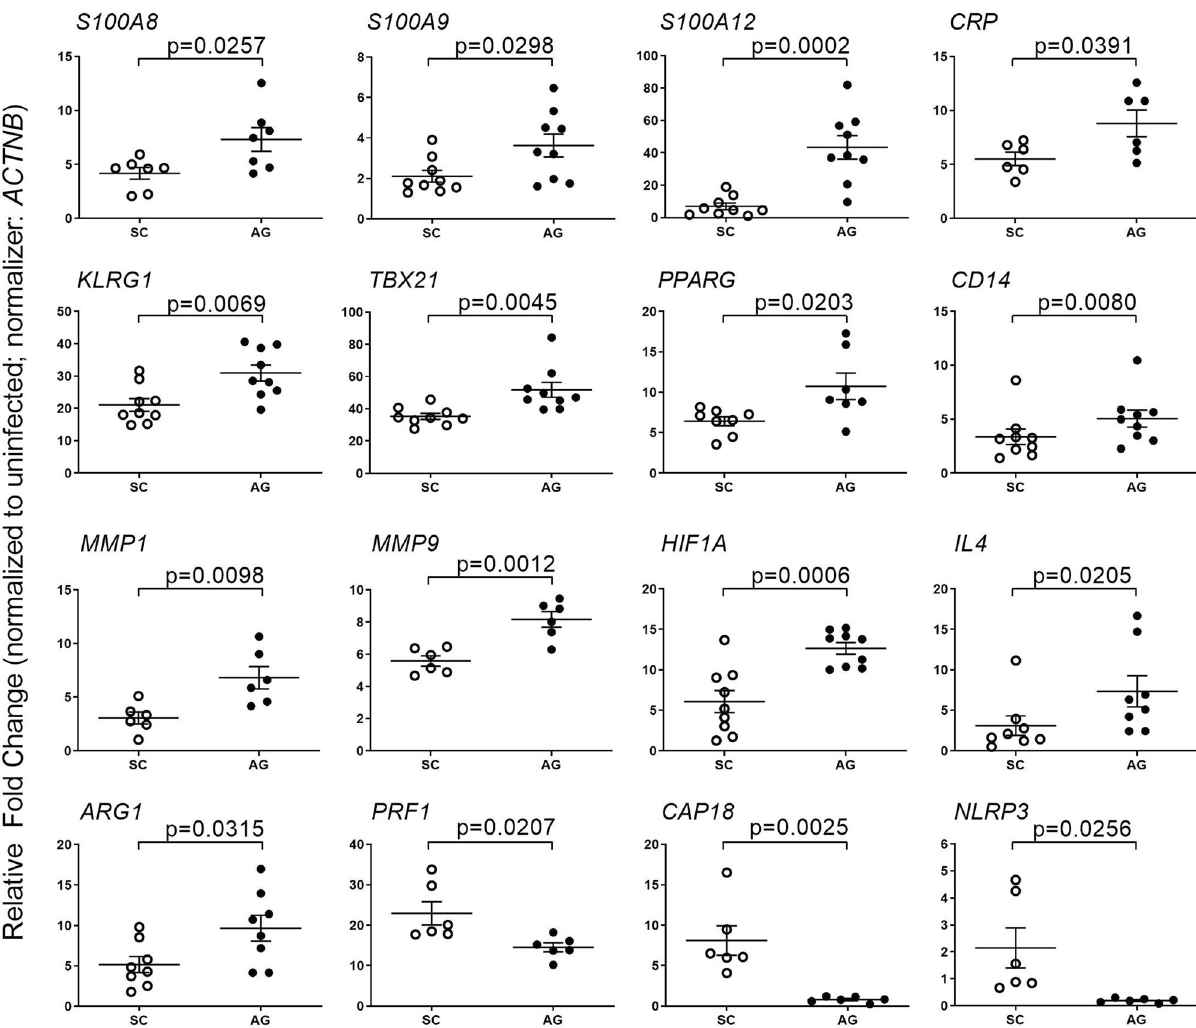
Fig. 5 Modulation of host in fl ammatory response gene expression in Mtb-AG- and Mtb-SC-infected rabbit lungs. qPCR was used to measure the expression of selected host in fl ammatory response genes at 24 h post infection. The expression level of genes in uninfected lungs was used to normalize their corresponding levels in Mtb-AG and Mtb-SC infected samples. Beta-actin gene ( ACTNB ) expression level was used as internal calibration control for each sample. The experiment was performed with n = 3 – 4 rabbits per group per time point and repeated at least twice. p value was calculated using Mann – Whitney U